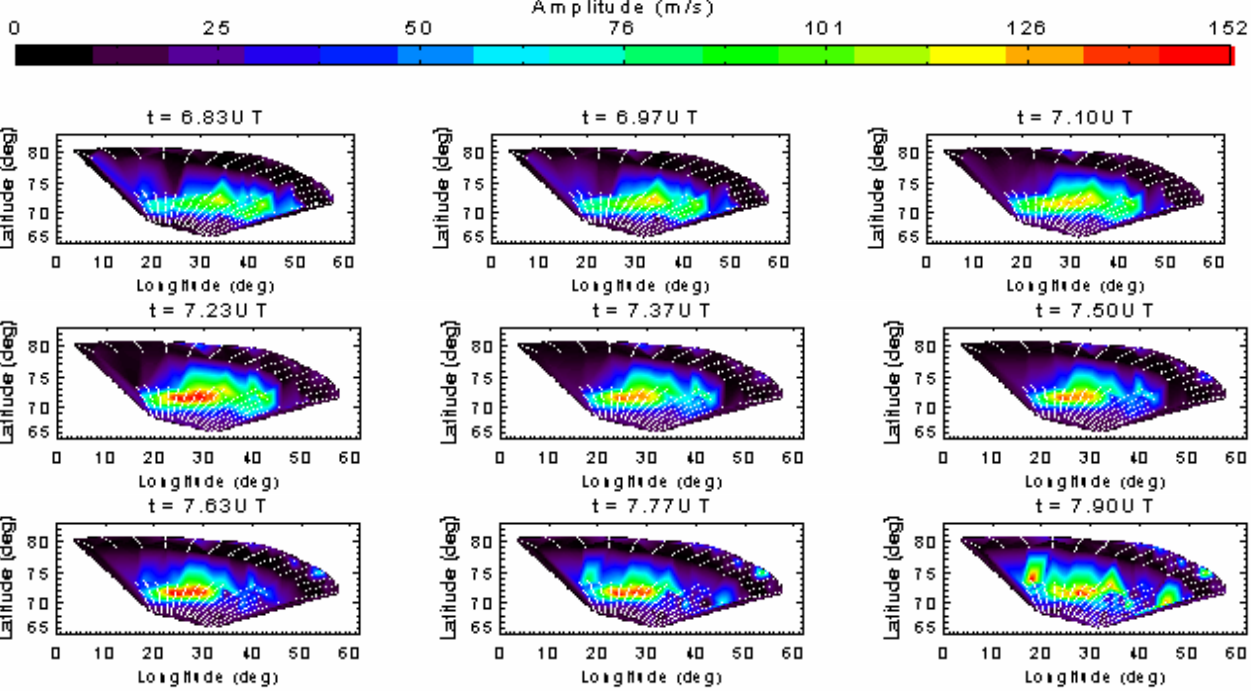
Fig. 5. The snap shots of the instantaneous amplitude of the 1.9 spectral component observed by the Goose Bay HF radar every after 8 min from 6.83 to 7.90 UT. The figure shows that this component was observed from 6.8 to 7.8 UT giving the temporal extent of about an hour.